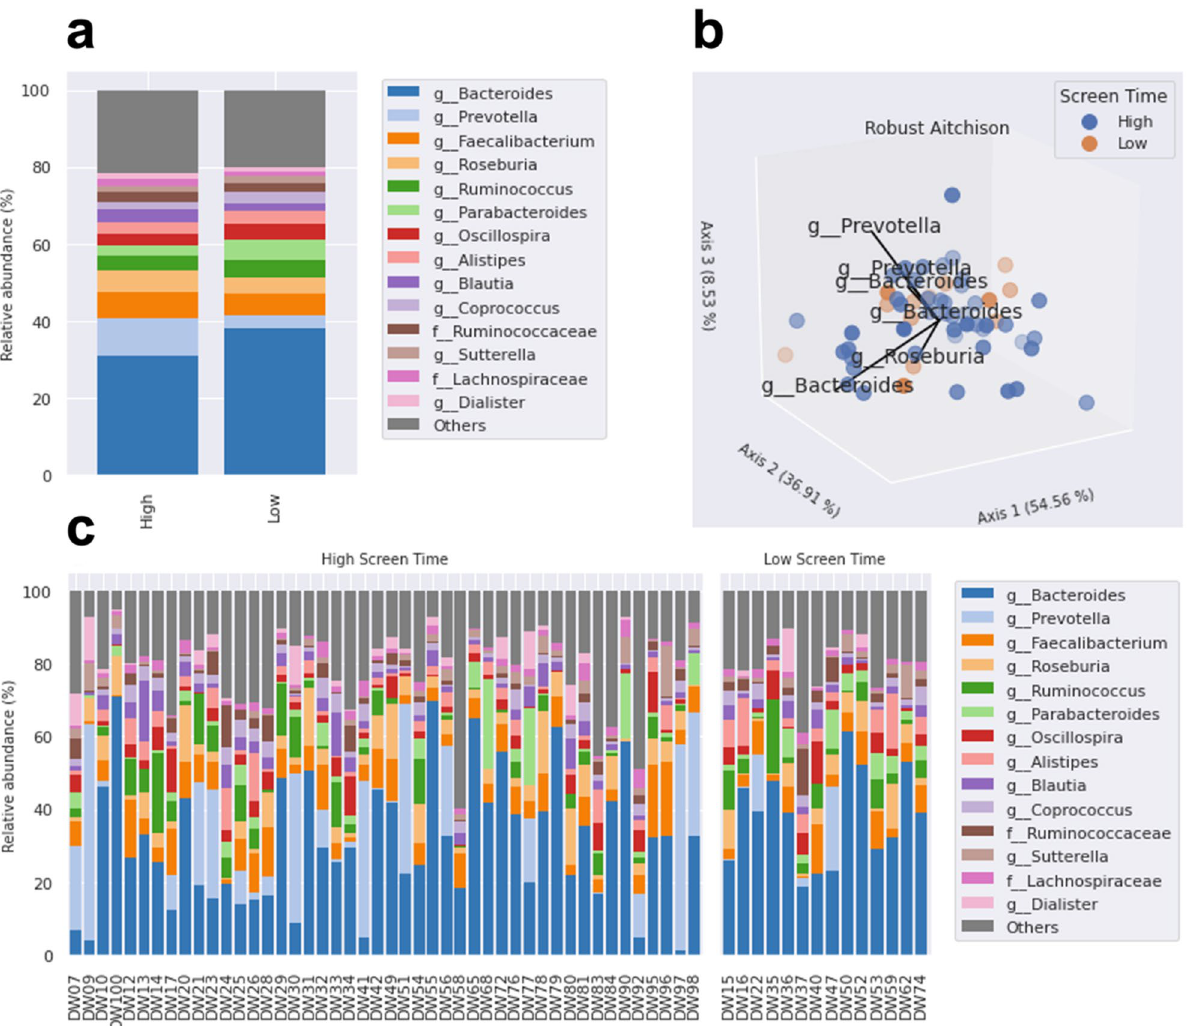
Figure 3. Taxonomic analysis of microbiota between groups. ( a ) Taxonomy bar plot of the top 15 most abundant taxa at the genus level for both groups ( n = 60). Less abundant taxa, representing ~ 19.5% of relative abundance, are not displayed. ( b ) Robust Aitchison PCA generated from DEICODE showing taxa (arrows) correlated with screen time classification ( n = 58). ( c ) Taxonomy bar plot of individual subjects at the genus level by high and low screen time groups ( n = 60). Less abundant taxa are not displayed. Note, where resolution at the genus level was not possible taxa are described at the lowest feature level obtained (i.e., f =